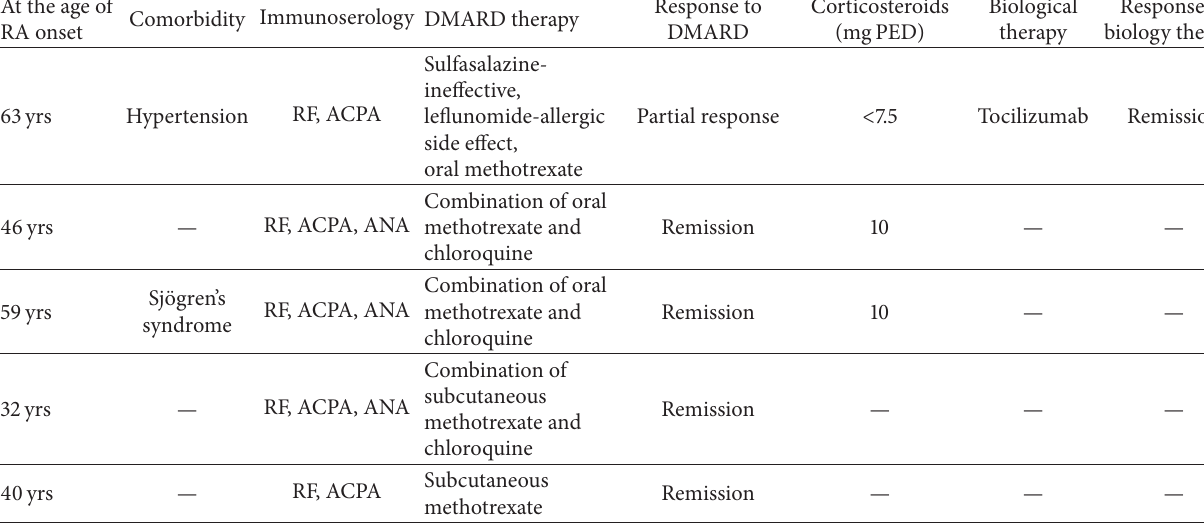
Table 2: Patient characteristics with rheumatoid arthritis